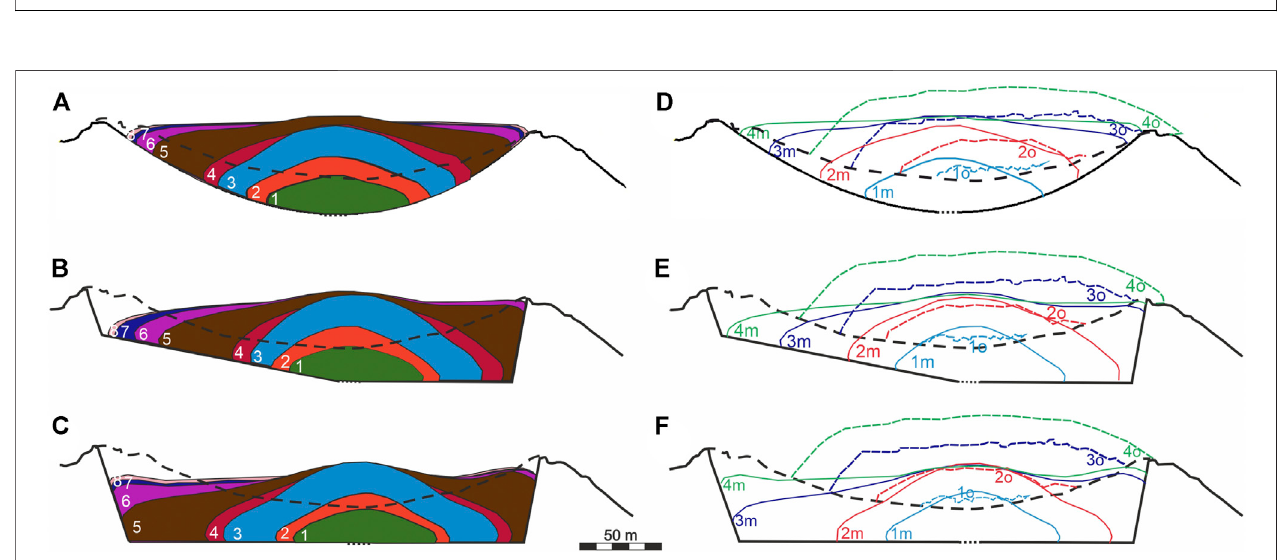
FIGURE 10 | Lava dome growth in experiment 7 (A, D) , 8 (B, E) , and 9 (C, F) . See Figure 6 for notations.